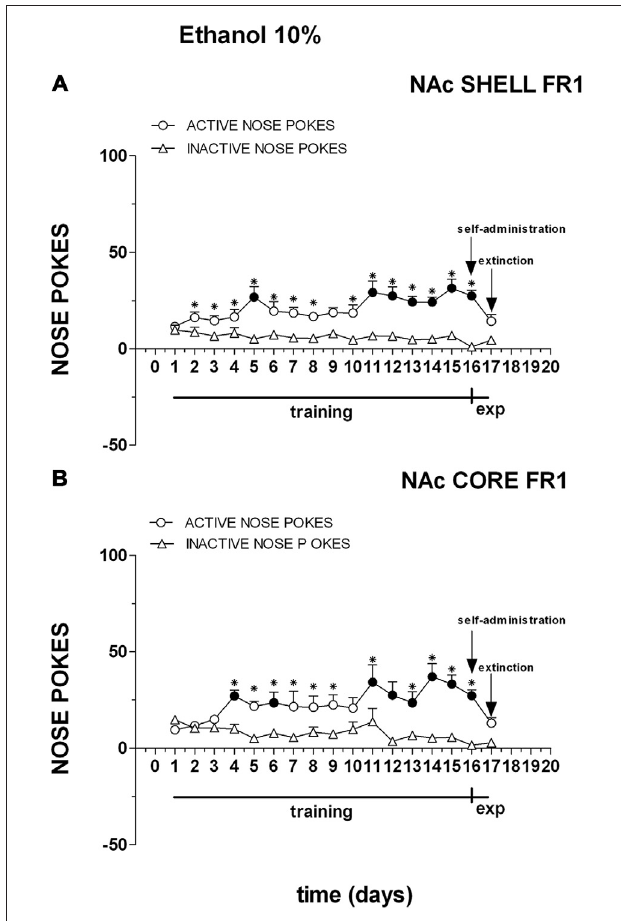
FIGURE 8 | Cumulative active (circles) and inactive (triangles) nose-pokes during training for FR1 responding for 10% ethanol solution and during dialysis experiments. Data are means ± SEM of the results obtained in rats implanted with guide cannulas in the NAc shell (A) ( N = 7) and rats in the NAc core (B) ( N = 7). Filled symbols, p < 0.05 vs. 1st day; ∗ p < 0.05 vs. inactive nose